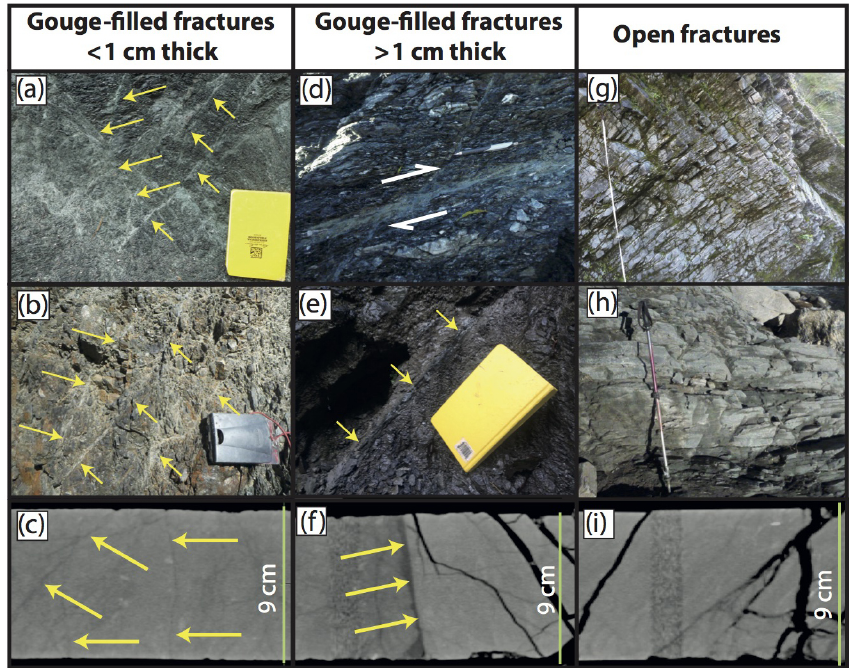
Figure 8. Examples of the three main types of fractures observed in the field around the Alpine Fault, and correlative fractures in DFDP-1 CT scans. (a–c) Thin gouge-filled fractures (yellow arrows) have a range of orientations and are found exclusively within 160m from the fault. They are equivalent to type iii fractures from Williams et al. (2016). (d–f) Thicker gouge- and cataclasite-filled fractures are equivalent to type i and ii fractures of Williams et al. (2016) and may be observed at all distances from the Alpine Fault. Offset markers can be observed across these fractures (e.g. the vein indicated by the pen and white arrows in panel d ). (g–i) Open fractures are mainly foliation parallel. Equivalent to type v fractures of Williams et al. (2016). Location of field photos: (a) Waikukupa thrust (43 ◦ 26 (cid:48) 34.7 (cid:48)(cid:48) S, 170 ◦ 04 (cid:48) 10.9 (cid:48)(cid:48) E), (b) Stony Creek 2, (d) Havelock Creek 2, (e) Bullock Creek, (g) Stony Creek (43 ◦ 22 (cid:48) 23.92 (cid:48)(cid:48) S, 170 ◦ 12 (cid:48) 53.63 (cid:48)(cid:48) E), (h) Havelock Creek 4. Compass clinometer is 8cm and yellow notebook is 20cm in length. Measuring tape in panel (e) is 1.1m long; walking pole in panel (g) is 1m in length. DFDP-1 CT scan intervals: (c) DFDP-1B 56-2 125.35–125.49m, (f) DFDP-1B 35-1 102.00–102.15m, (i) DFDP-1B